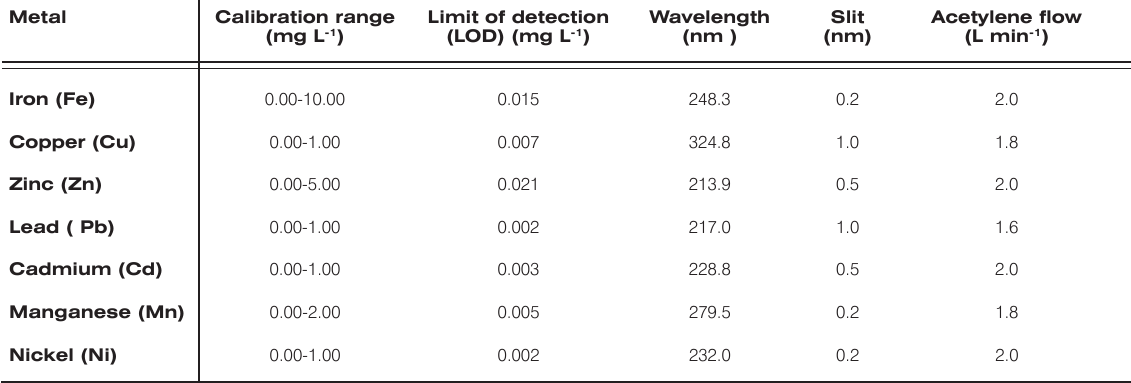
Table 2. Working conditions and limits of detection.